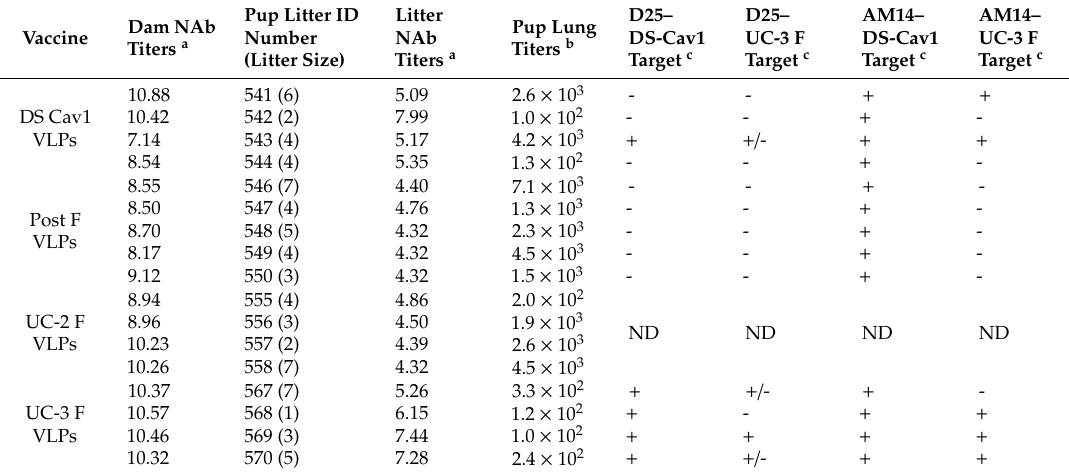
Table 1. Summary of Properties of Dam and Pup